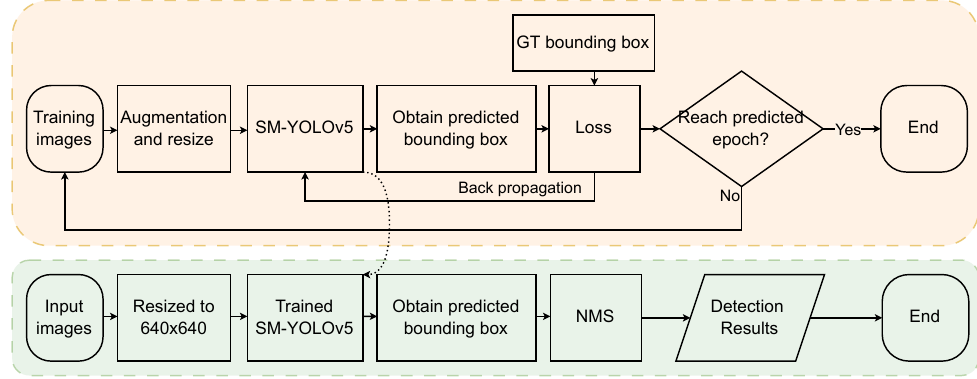
Figure 4. Flowchart illustrating the training and detection process of SM-YOLO, with the training phase represented by orange boxes and the detection phase represented by green